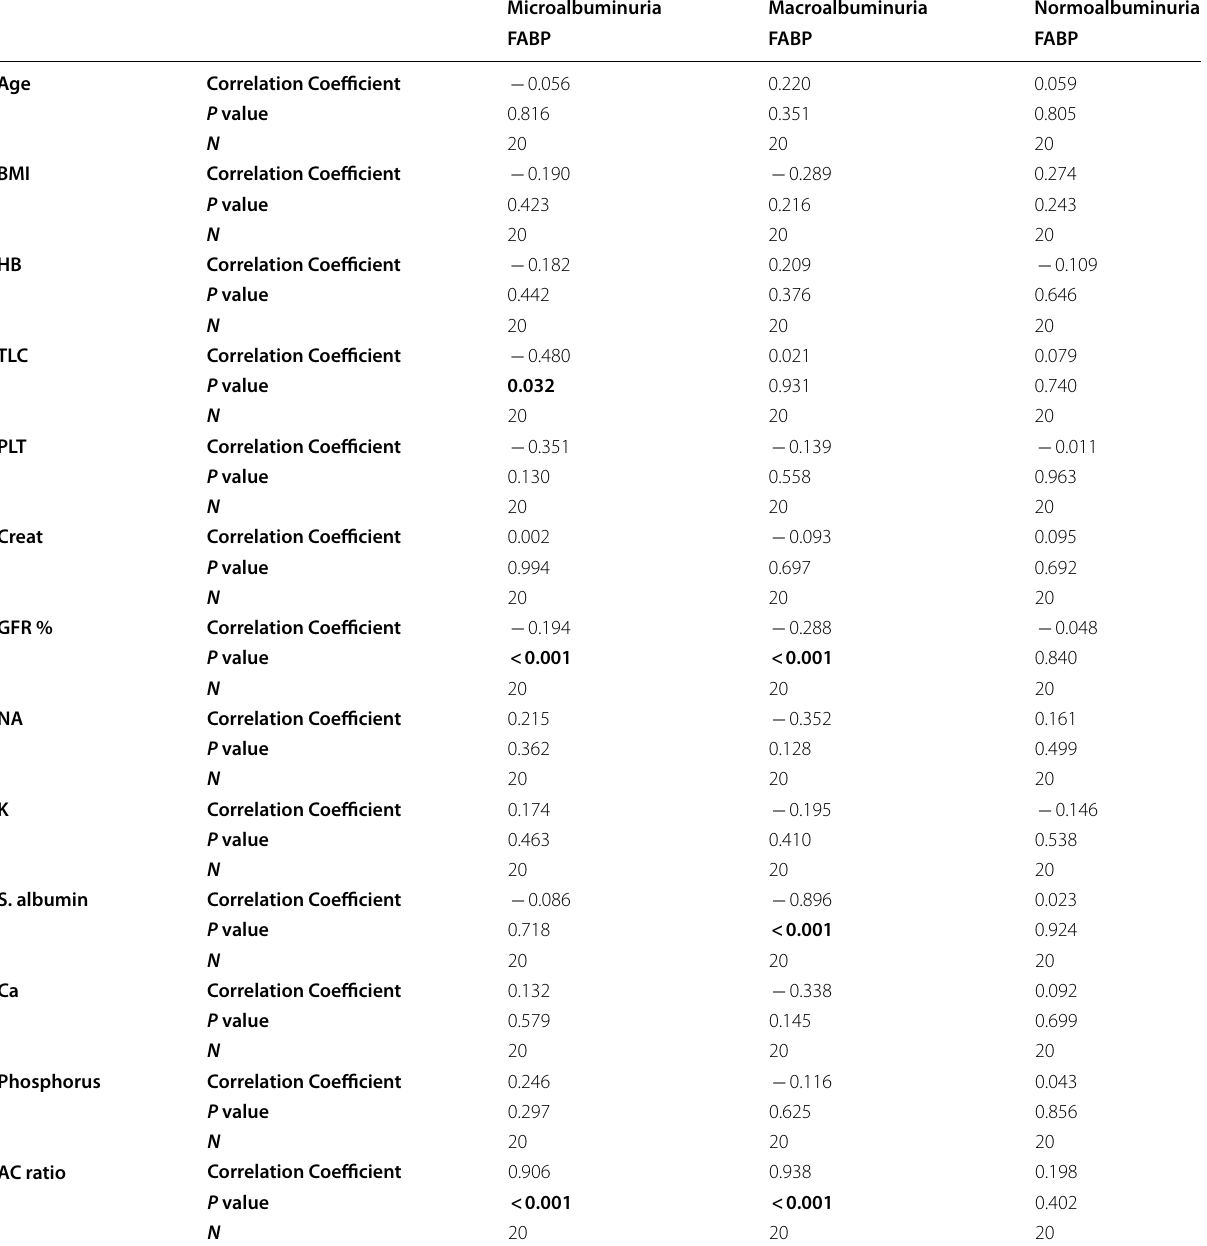
Table 7 Correlation analysis between serum FABP4 (ng/L) and other studied parameters in studied diabetic